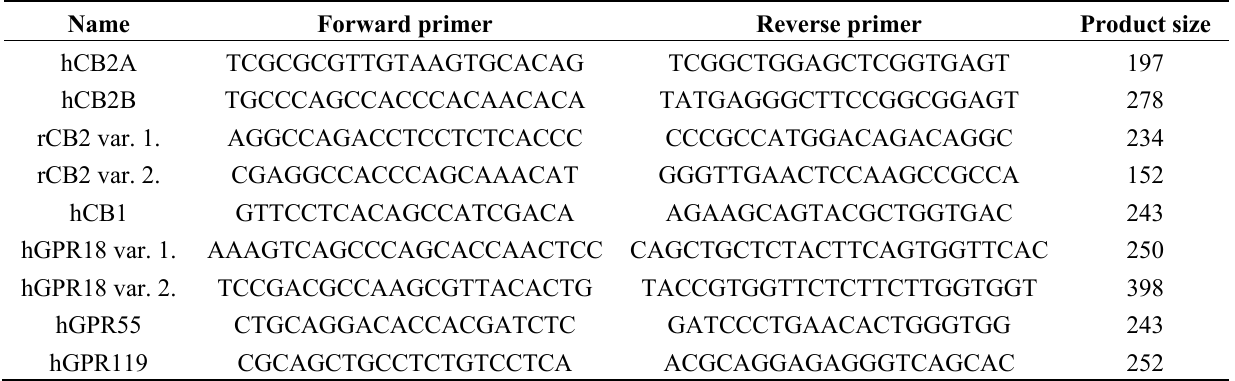
Table 1. Primers used for